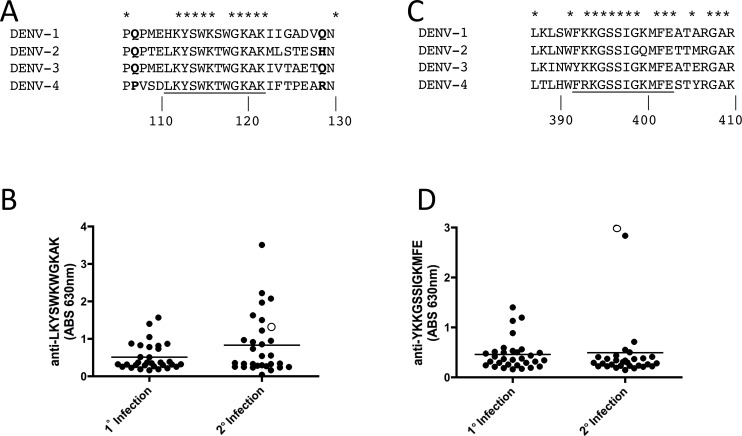
NS1 and E enriched epitopes identified by deep sequence-coupled biopanning with patient serum after two rounds of biopanning.NS1 conservation (A) is shown for the highly enriched overlapping peptides from patient 1536 after two rounds of biopanning. Bold letters indicate the flanking amino acids that are solved in the crystal structure (see Fig 5F for structure). E conservation (C) is shown for the most enriched overlapping peptides from patient 1536 after two rounds of biopanning. ELISAs against synthetic peptides representing the NS1 epitope (B) and the E epitope (D) are shown. Open circles represent the data point for patient 1536 (the sample used to identify the epitopes). Primary serum samples (n = 31) and secondary serum samples (n = 30) isolated from patients 7 days post onset of fever were used.